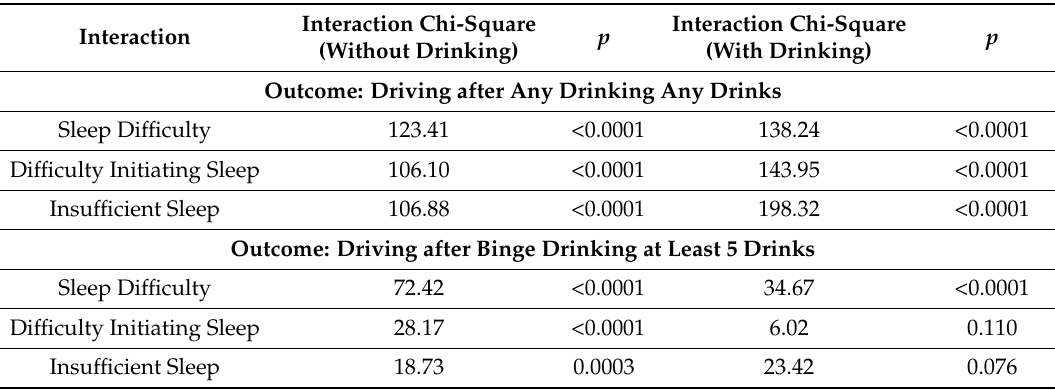
Table 2. Athlete Status by Sleep Interactions on Driving After Drinking Alcohol, With and Without Adjustment for Amount of